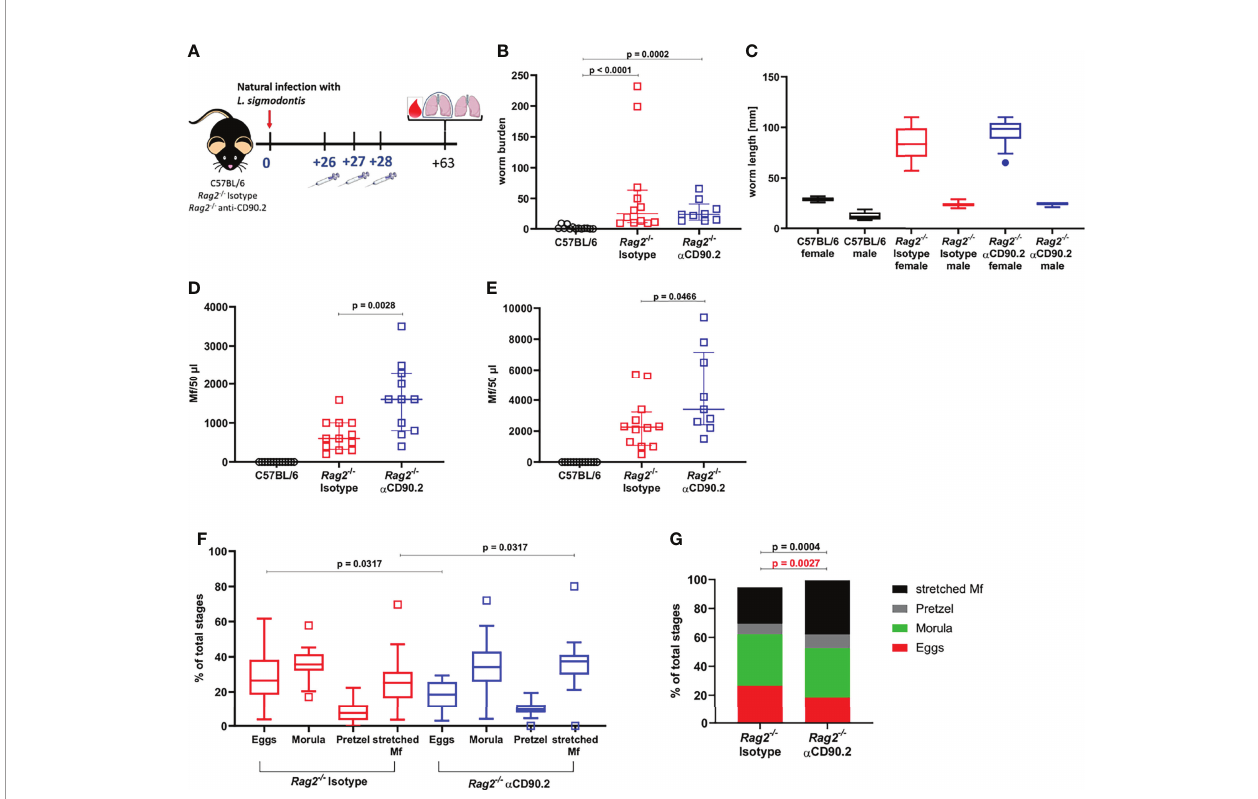
FIGURE 4 | ILC2 depletion enhances the micro fi larial load in L. sigmodontis -infected Rag2 -/- mice. (A) Experimental setup of ILC2 depletion in Rag2 -/- mice. (B) Adult worm burden in naturally L. sigmodontis -infected C57BL/6 mice, Rag2 -/- mice and ILC2-depleted Rag2 -/- mice at 63dpi. (C) Worm length [mm] of female and male worms at 63dpi. (D) Micro fi lariae (Mf) count in 50µl peripheral blood at 57dpi and (E) 63dpi. (F) Embryonic stages (egg, morula, pretzel, stretched Mf) of female worms 63dpi. (G) Distribution of embryonic stages [% of total stages] in female worms 63dpi. (B, D, E) n = 11-13 mice, pooled data from 2 independent experiments. (C) n = 2 worms for female worms of C57BL/6 mice, n = 6 worms for male worms of C57BL/6 mice, n = 20 worms for female and male worms of Isotype-treated Rag2 -/- mice, n = 14-15 for female and male worms of a CD90.2-treated Rag2 -/- mice; data shows 1 representative experiment from 2 independent experiments. (F, G) n = 25-28 female worms per group, data from 1 experiment. (B) Data shown as median with IQR, Kruskal-Wallis with Dunn ’ s post-test. (C) Data shown as a Tukey Box and Whiskers blot, Kruskal-Wallis with Dunn ’ s post-test was used to assess statistical signi fi cance. (D, E) Data shown as median with IQR, Mann-Whitney test for the comparison of Isotype-treated Rag2 -/- mice with a CD90.2-treated Rag2 -/- mice. (F) Data shown as a Tukey Box and Whiskers blot, Kruskal-Wallis with Dunn ’ s post-test was used to assess statistical signi fi cance. (G) Mann-Whitney